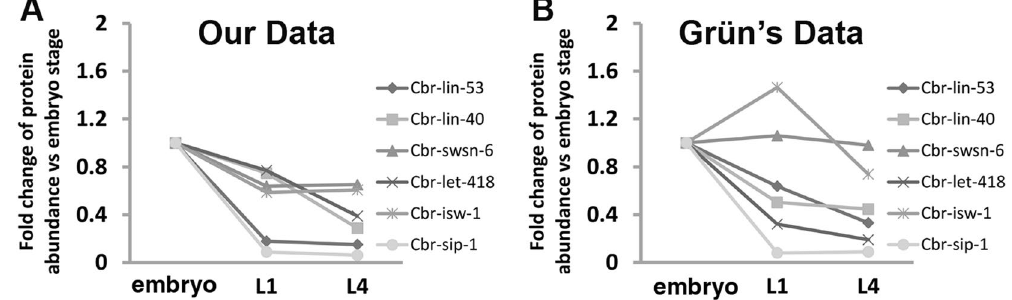
Figure 5. Expression dynamics of a subset of six chosen proteins that are up-regulated in embryo across different developmental stages, including embryo, L1, and L4 stage. ( A ) Data from this study. ( B ) Data from a previous study 29